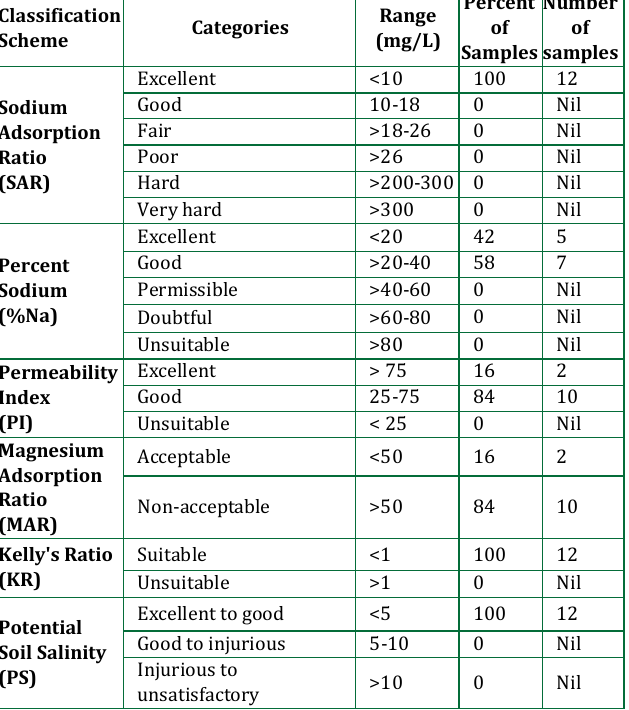
Results interpretation for the various irrigation water quality models for Gokana L.G.A. Classification